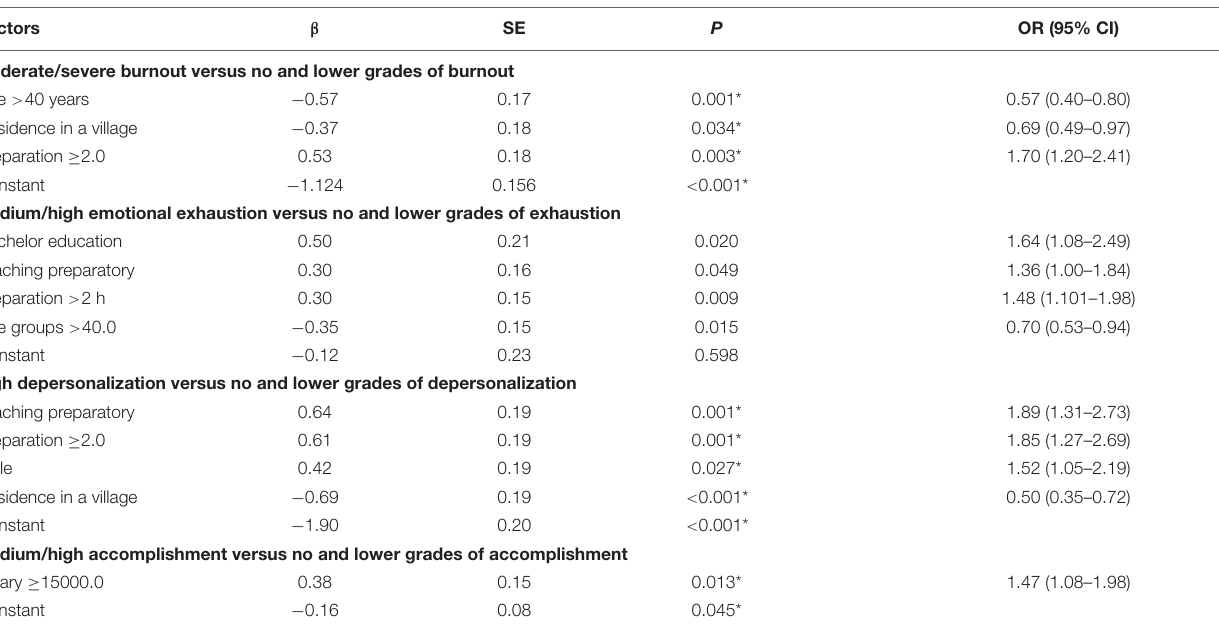
TABLE 3 | Logistic regression analysis for factors affecting burnout and its